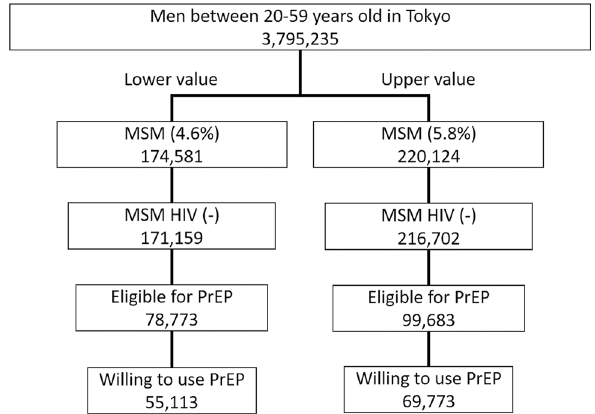
Figure 7. Estimation of the number of men who have sex with men (MSM) who are eligible for pre-exposure prophylaxis (PrEP) in Tokyo. The population denominator was based on the number of males aged 20–59 years in Tokyo. The left side represents the lower values of the number of MSM who meet each criterion and the right side represents the upper